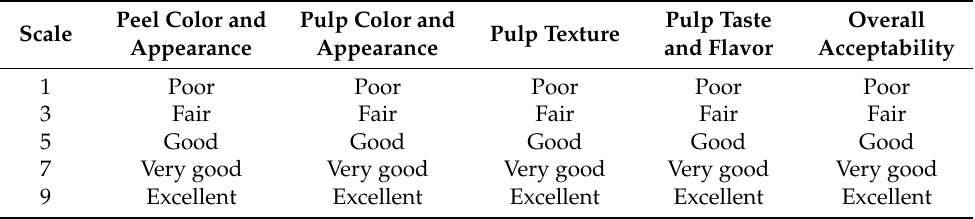
Table 2. Hedonic scale rating for various sensory